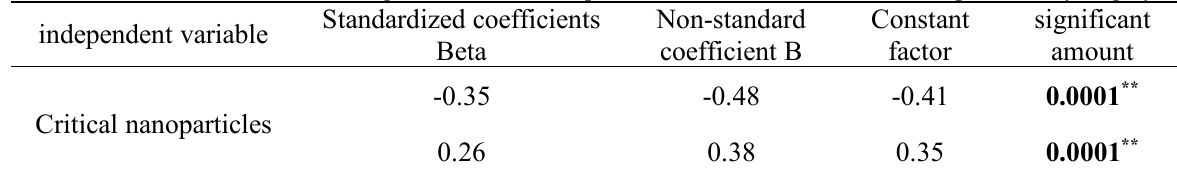
Table 4. Critical factors determining the effect of nanoparticles on income and medical expenses